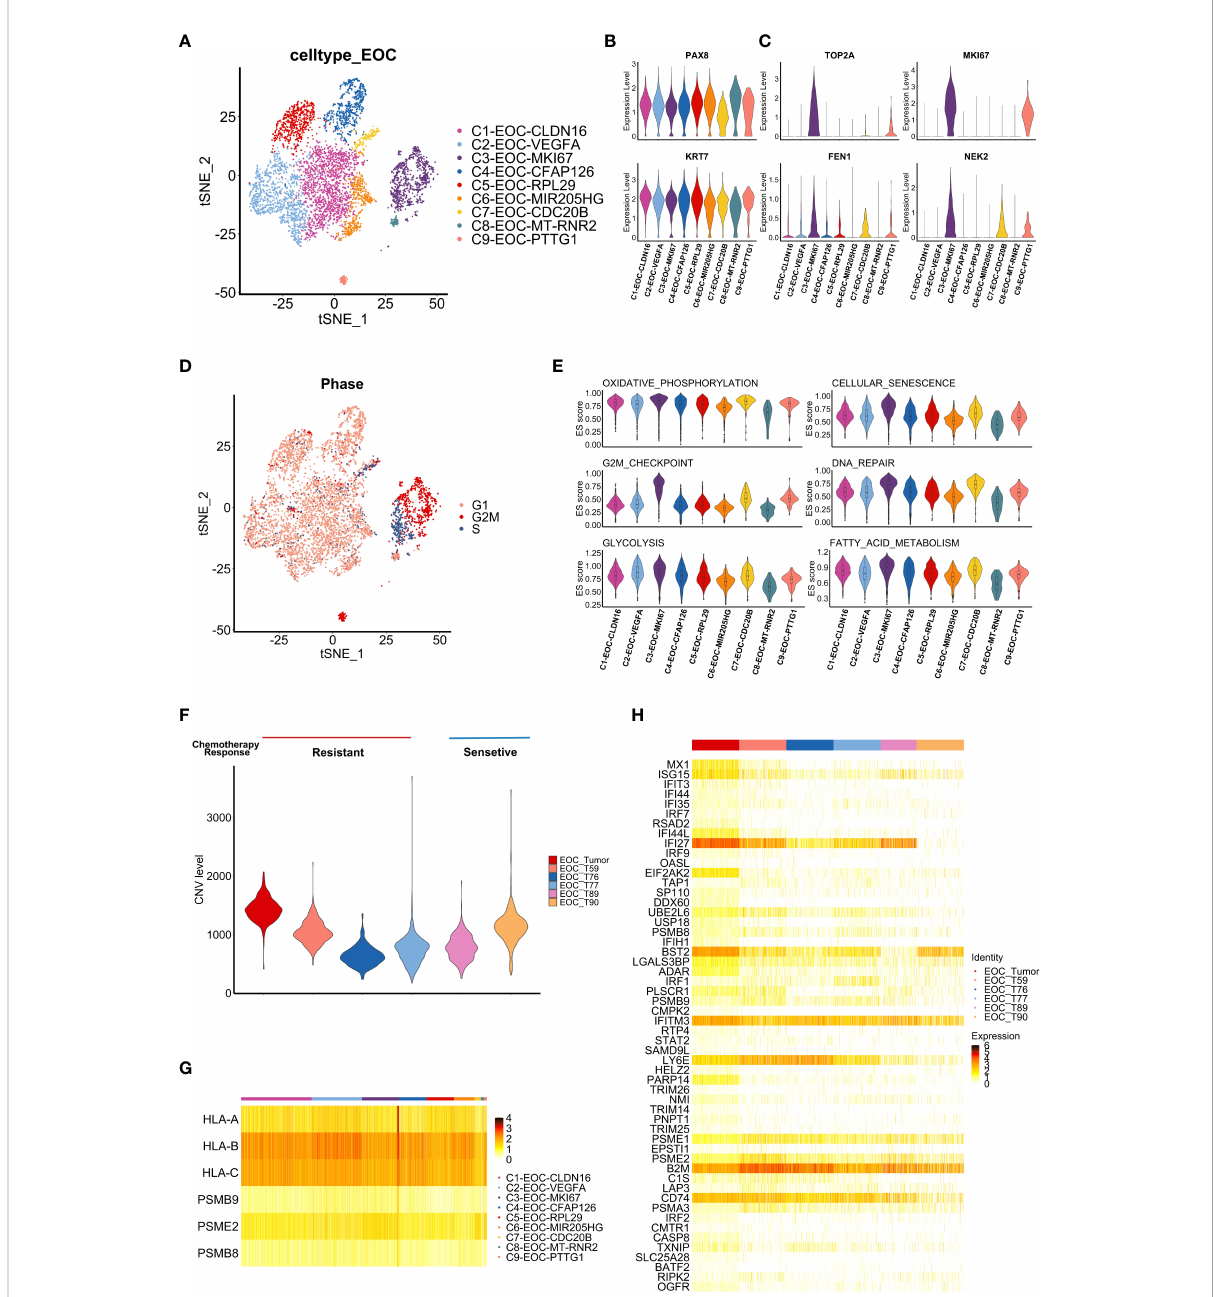
FIGURE 2 Tumor-intrinsic features uncovered by single cell analysis. (A) t-SNE visualization of tumor cell subclusters from samples Tumor and Ascites , colored by tumor cell subclusters. (B, C) Violin plots display the expression offallopian tube epithelium (FTE) markers (B) and chemotherapy resistance- related genes (C) in each tumor cell subclusters. Distribution of the per cell signature expression Is based on normalized data. (D) t-SNE visualization of cell cycle phases of tumor cells in sample Tumor and Ascites , colored by cell cycle phase. (E) Violin plots shows the enrichment level of speci fi c pathways among each tumor cell subcluster. Distribution of the per cell signature expression was based on the GSVA scores. (F) Violin plot shows CNV level among tumor cells from our data and fi ve additional HGSOC samples. ( Tumor, T59, T76 , T77 : chemo-resistant; T89 , T90 : chemo- sensitive) (G) Heatmap shows the expression of antigen presentation related genes in tumor cell subclusters from sample Tumor . (H) Heatmap shows the expression of interferon response pathway-associated genes in tumor cells from six HGSOC samples ( Tumor, T59, T76, T77, T89, T90